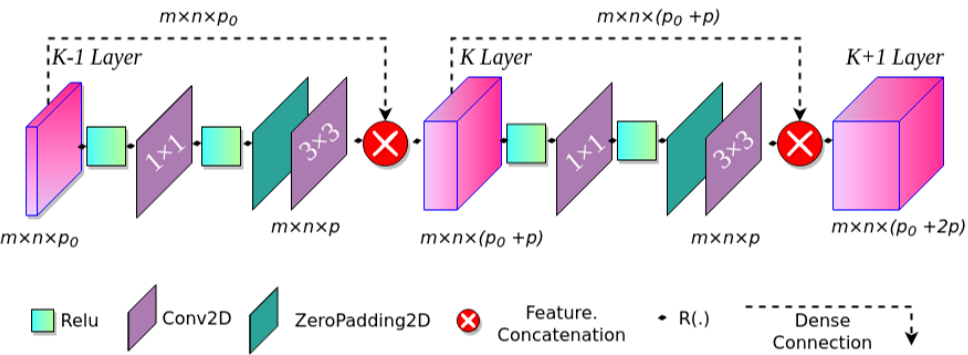
Figure 4. Structure of dense block.